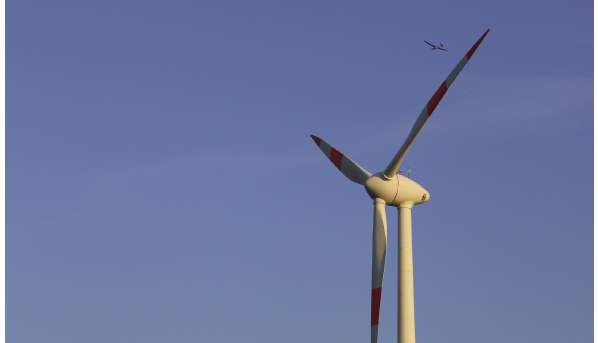
Figure 2. Research UAS MASC Mk 3 in front of an Enercon wind energy converter at the Jade Wind Park in July 2018. (Photo taken by the author.)